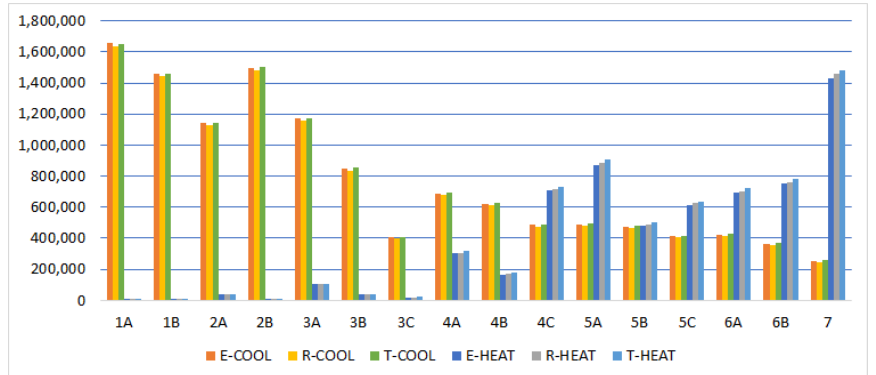
Fig. 6. Heating-cooling load comparison on 3